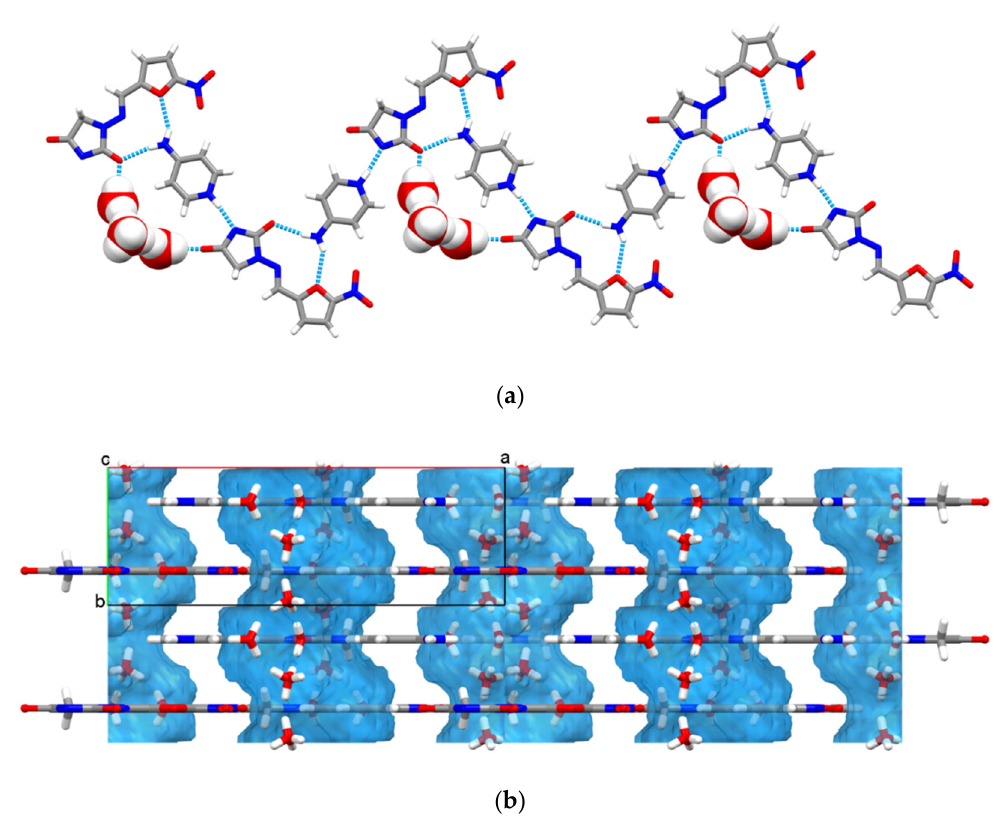
Figure 3. Crystal packing of the [NFT+4AmPy+H 2 O] salt (1:1:4): ( a ) a planar zigzag chain of NFT-4AmPy dimers with hydrogen bonded tetramers of water molecules; ( b ) the calculated contact surface of lattice water molecules.